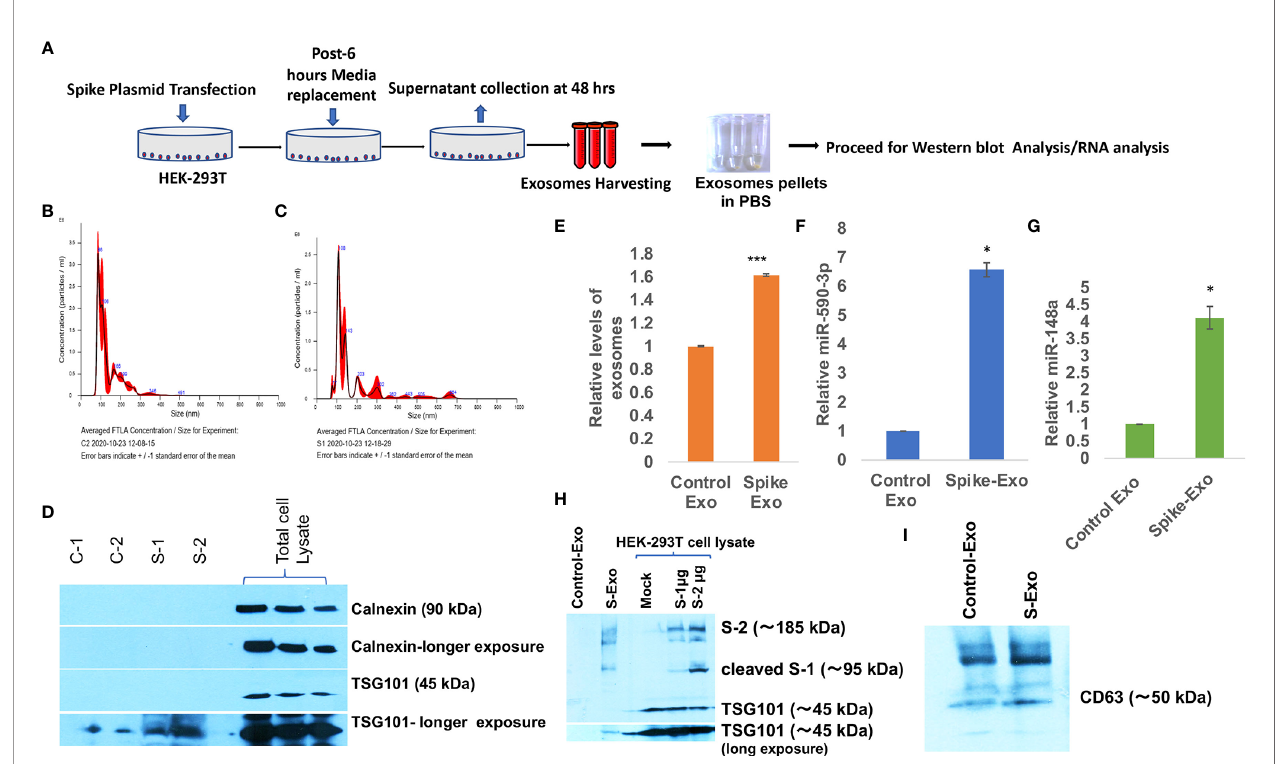
FIGURE 1 | Spike transfected cells released exosomes are loaded with miR-148a and miR-590. (A) Work- fl ow schematic depicting exosome harvesting protocol from Spike gene transfected HEK-293T cells. (B) Size distribution analysis graph of control exosomes done on NanoSight, NTA 3.2 Dev Build 3.2.16, indicating mode of size range 90.6 nm. (C) Size distribution analysis graph of S-exosomes, indicating mode of size range of 107.5 nm. (D) Immunoblot image for characterization of harvested exosome preparations. Endosomal protein Calnexin is absent in exosome population indicating the purity of exosome and free of cellular debris. TSG101 as tetraspanin marker protein are present in exosomes. (E) Graph bars showing relatively higher amount of exosome secretion by Spike transfected cells, measured as total protein via Bradford assay. (F) Graph bars displaying relative miR-590 levels in Spike-Exosomes compared to control exosomes. (G) Graph bars displaying relative levels of miR-148a in Spike-Exosomes as compared to control exosomes. Exosomes pellets were subjected to total RNA isolation and microRNA levels measured through qPCR analysis via TaqMan assay speci fi c for miR-590 and miR-148a respectively. (H) Western blot image, con fi rming the Spike gene transfection in HEK-293T cells as well their accumulation in secreted exosomes. 1µg and 2 µg of Spike gene (S) plasmids (pTwist-EF1 a -nCoV-2019-S- 2×Strep) were transfected in 6-well plate format for 24 hours with the help of Lipofectamine 2000. (I) Western blot image showing CD63 in harvested exosomes as exosomal marker. All the experiments have been repeated at least three times independently to obtain mean and mean ± S.E.M. Levels of signi fi cance have been calculated by student ’ s t-test and statistical signi fi cance indicated as single * for p values <0.05 and *** for p values